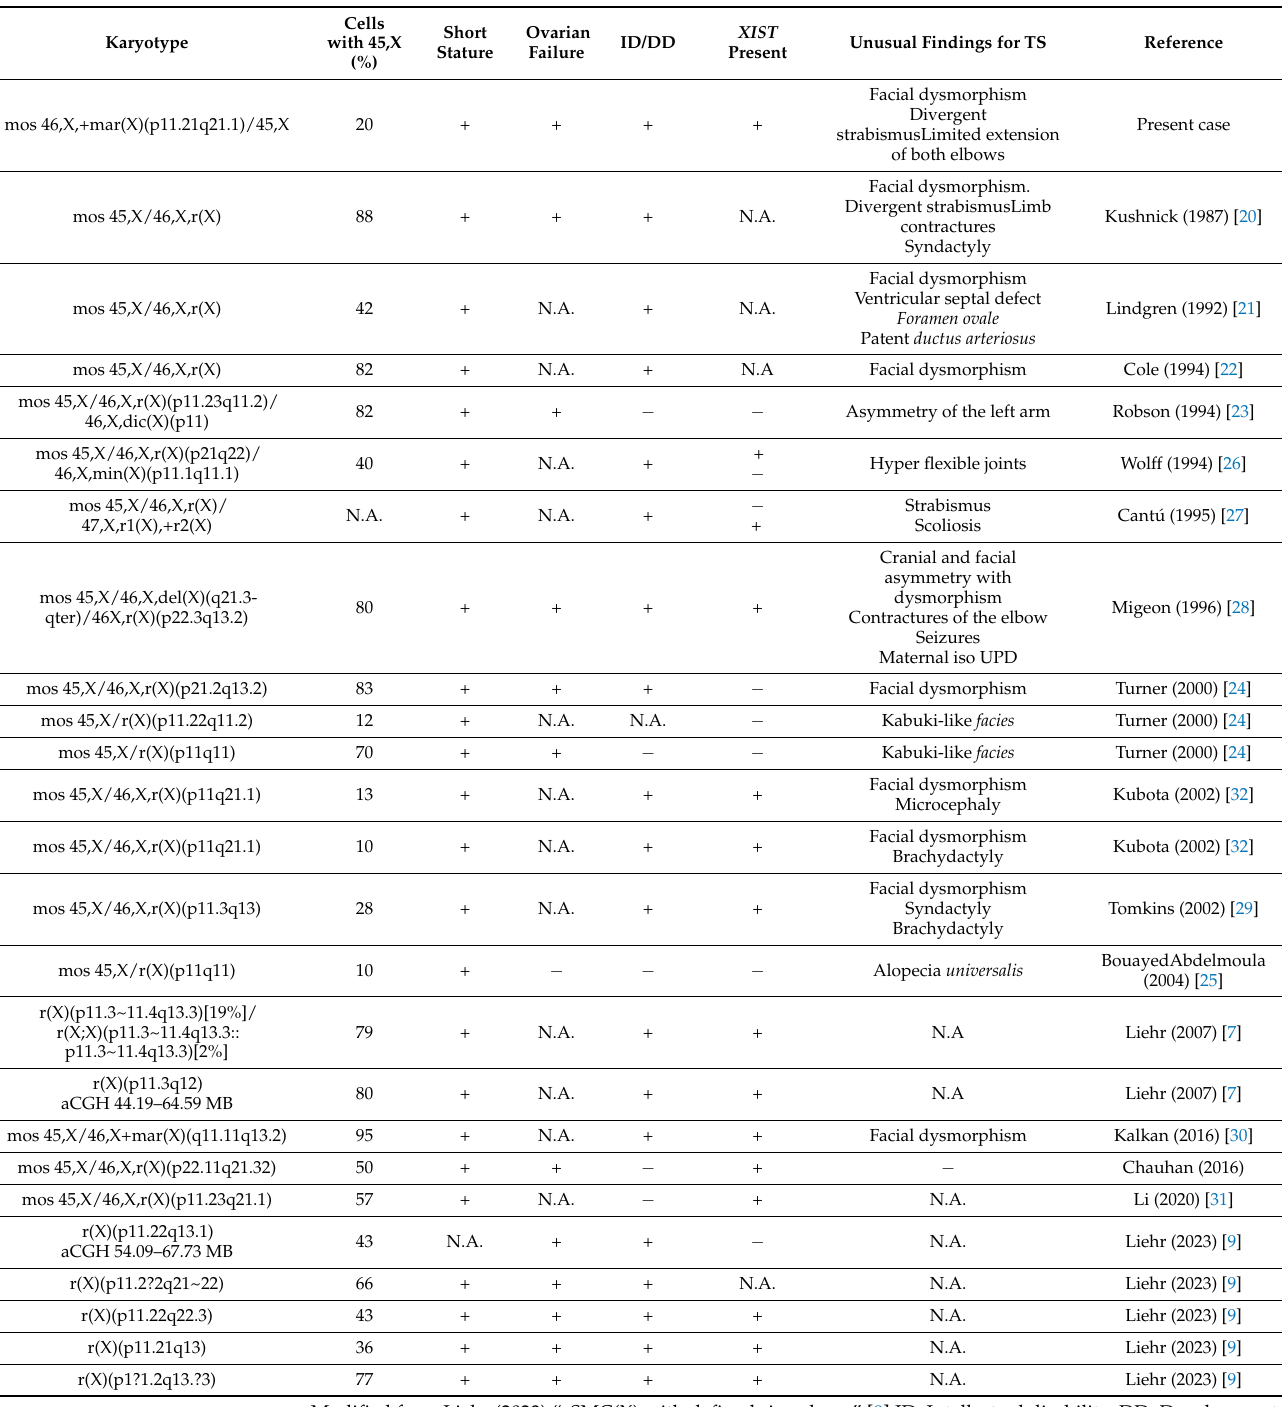
Table 1. Clinical comparison of patients with an sSMC T or small ring derived from the X